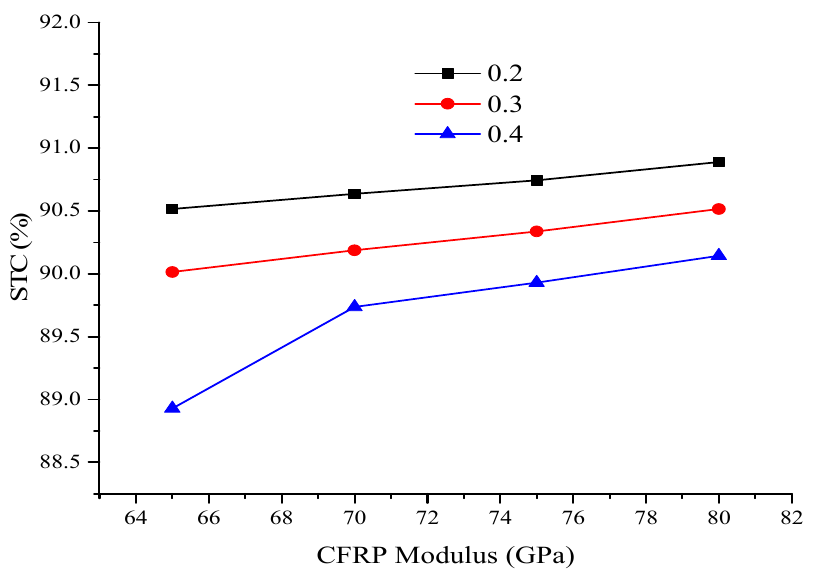
( b ) Variation of STC with CFRP modulus at various CFRP Poisson’s ration ( v P ) when v A is 0.3. Figure 11. Influence of packaging modulus and Poisson’s ratio on STC.